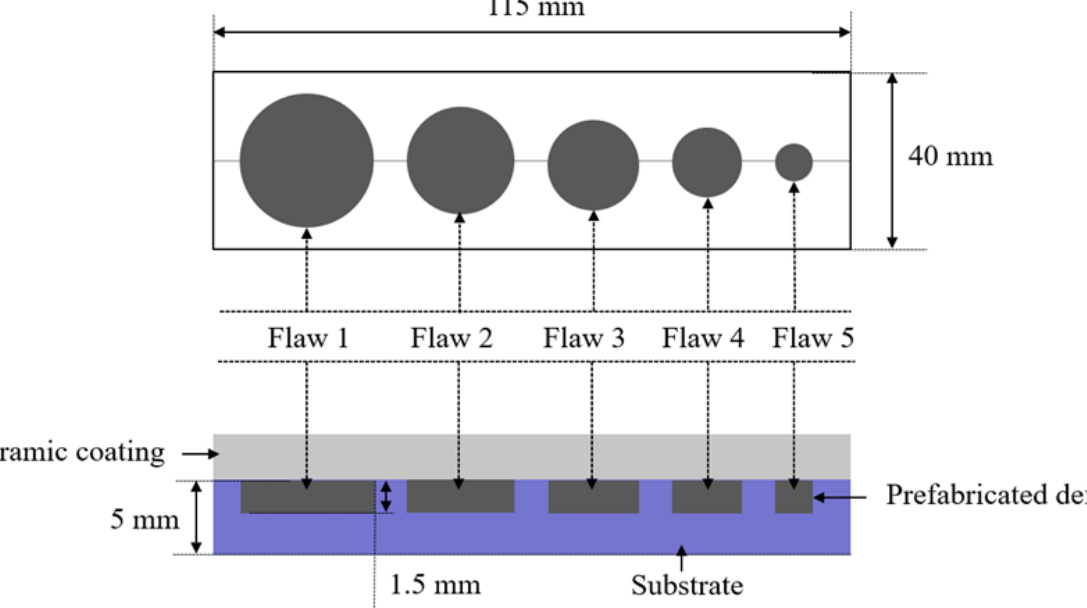
Figure 1. The schematic diagram of the dimension of the sample